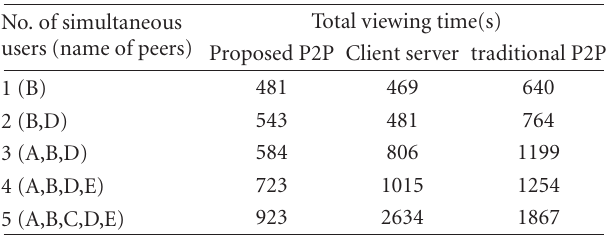
Table 7: Total view